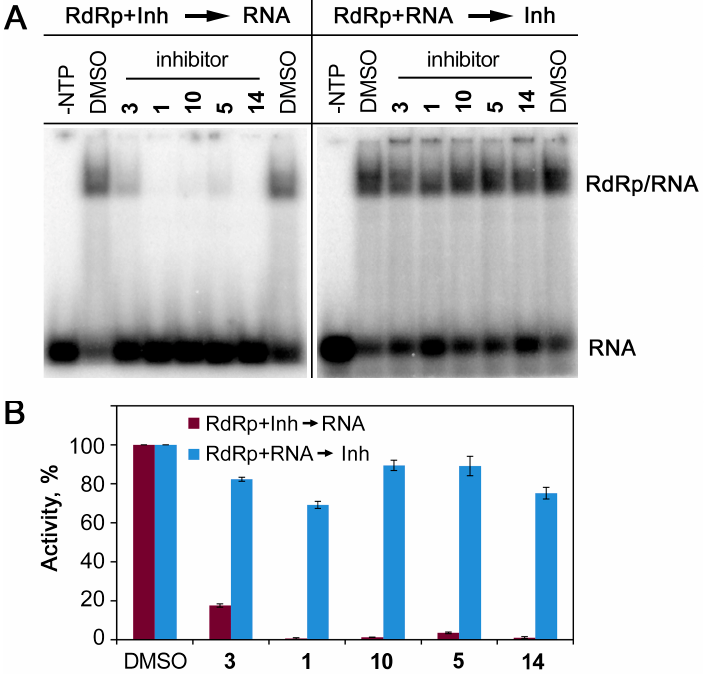
Figure 4. Inhibition of RNA binding by RdRp by the tested inhibitors. ( A ) Analysis of RNA-RdRp binding by EMSA. (Left) RdRp was first pre-incubated with indicated inhibitors and then the pri- mer–template RNA substrate (labeled at the 5 ′ -end of the primer strand) was added. (Right) RdRp was first pre-incubated with the RNA substrate and then inhibitors were added. The samples were separated by non-denaturing PAGE. Positions of free RNA and the RdRp/RNA complex are indi- cated. ( B ) Quantification of data from panel A (averages from two independent measurements). In each case, RNA binding was normalized by the binding in the absence of inhibitors. To determine the range of inhibitory concentrations of these compounds in vitro, we titrated RdRp with compounds 1 , 5 , and 14 , then added the RNA substrate and measured the efficiency of RNA extension (Figure 5). The resulting IC 50 values for these compounds were 44±2, 72±20, and 244±58 µM, respectively, which corresponded to the range of their effective concentrations in cell-based assays (Table 1).